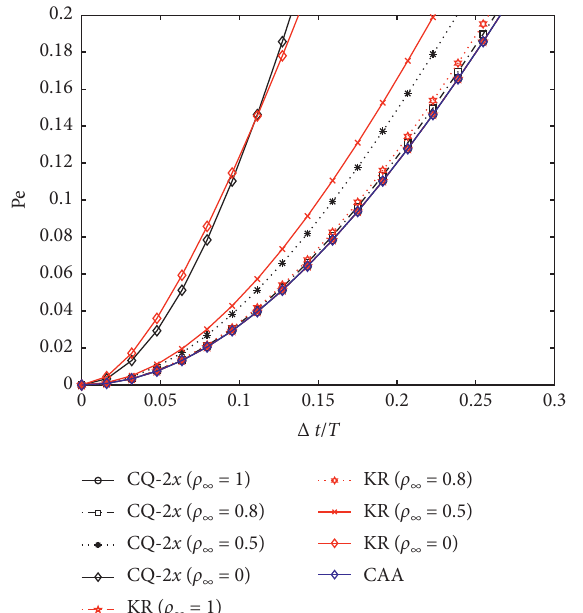
Figure 5: Relative period error of CQ-2 x when ξ � 0 . Figure 6: Numerical damping ratio of CQ-2 x when ξ � 0